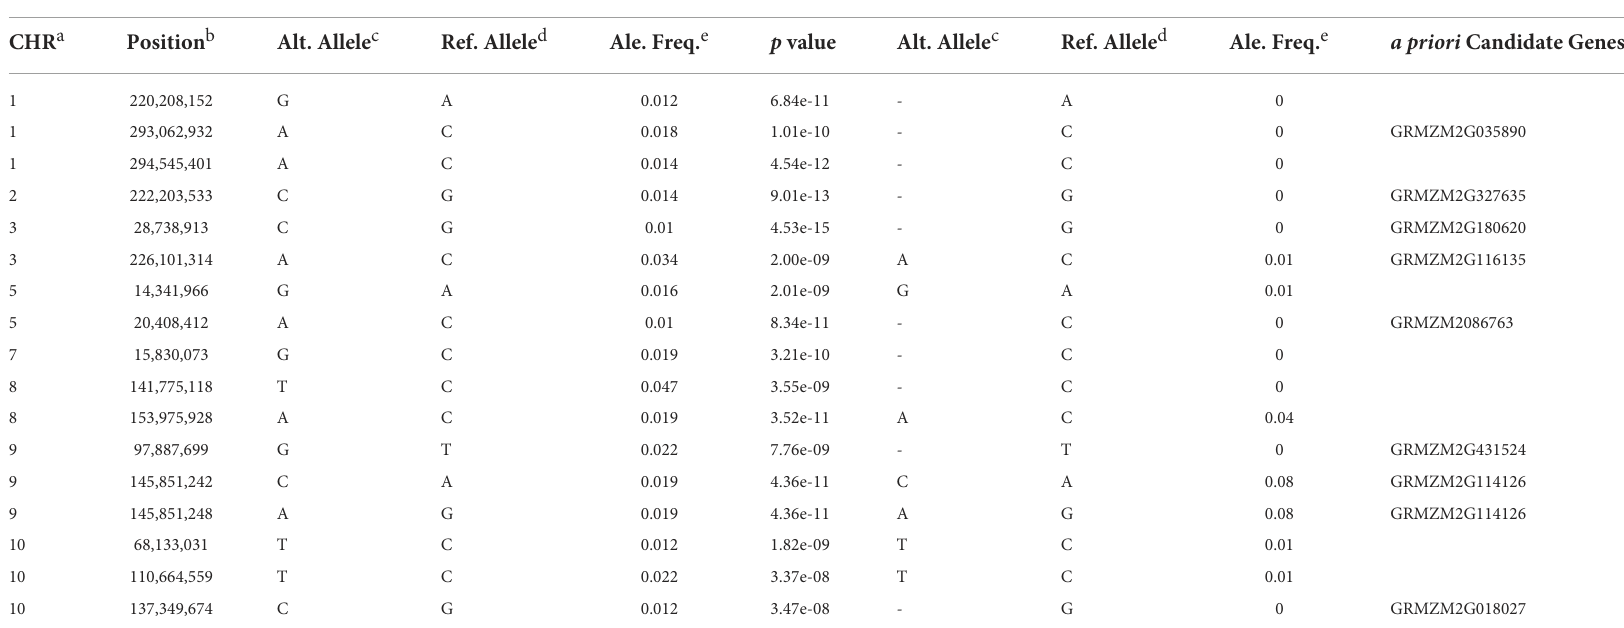
TABLE 4 Genome position, allele frequency, and the a priori candidate genes for GWAS SNP variants responsible for both TSC and grain yield in